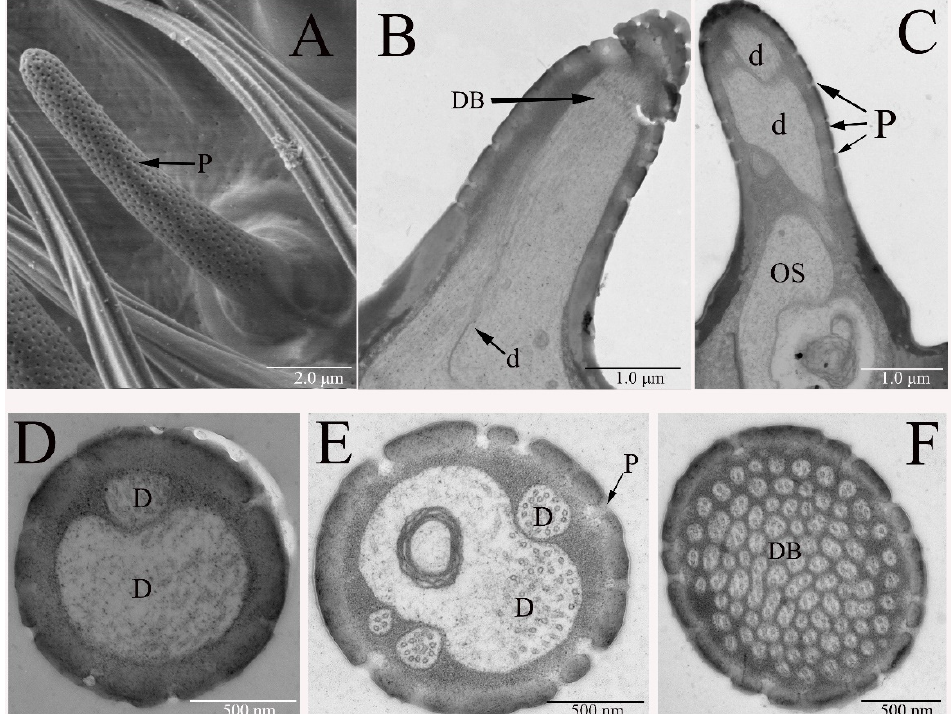
Figure 3. Sensilla basiconica subtype I on B. dorsalis antennae (AnSB-I): ( A ) AnSB I with conspicuous pores on male antenna. ( B ) A single dendrite (d) is divided into many dendritic branches (DB). ( C ) Longitudinal cross-section of AnSB-I on male adult antenna shows the outer dendritic segment (OS) at the basal part of the sensillum. ( D , E ) Cross-sections of AnSB-I mid-region show different numbers of dendrites in the lumen of a male antenna. ( F ) Cross-section of AnSB-I tip shows many dendritic branches divided by dendrites. The tubules with pores are observed on the cuticle. The ultrastructure of AnSB-I on the female antenna is same as that of the males.